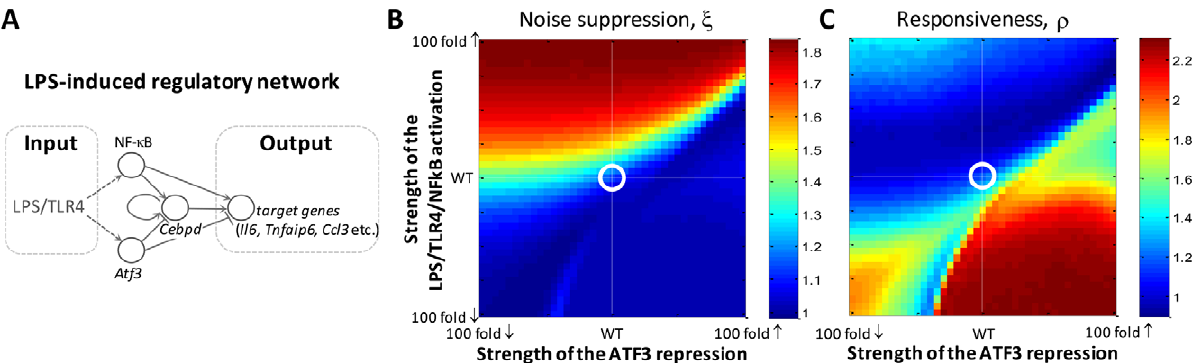
Figure 4. LPS-induced regulatory network driven by NF- k B, ATF3 and C/EBP d transcription factors lies at the boundary of responsiveness and noise suppression. (A) Schematic representation of the LPS-induced regulatory network. The network is comprised of overlapping positive and negative (coherent type 1 and type 2) feed-forward loops [24] in which LPS indirectly activates core transcription factors (NF- k B and ATF3) which regulate combinatorially target genes, such as the transcription factor C/EBP d , interleukin 6 (IL6), tumor necrosis factor, alpha-induced protein 6 (TNFAIP6), Ccl3 chemokine and others [22]. Network notation is described in Figure 1. (B, C) The j and r , respectively, of the LPS-induced regulatory network as a function of the strengths of the LPS/TLR4/NFkB activation and the ATF3 repression (see Text S1). Each point on the heat maps represents the averaged j and r , respectively, over 100 random and noisy stimuli (see also Figure S13). The strengths of the LPS/TLR4/ NFkB activation and the ATF3 repression are on a logarithmic scale. White lines represent WT parameters and their encircled intersection is the WT network.